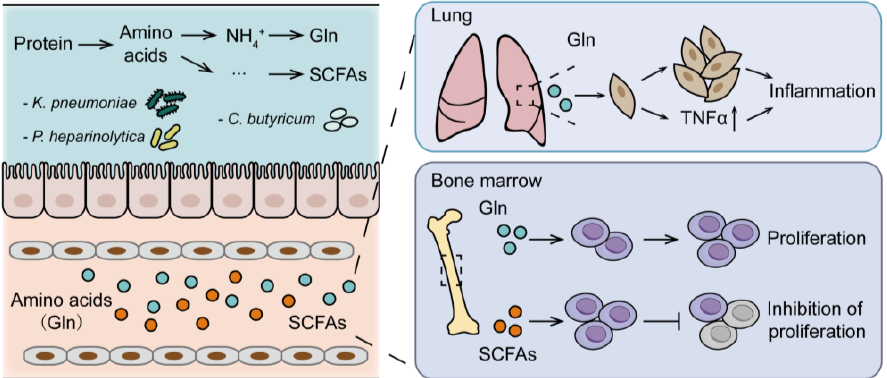
Figure 3. Interaction of gut microbiota and host amino acid metabolism in multiple myeloma. The amino acids are converted to ammonia. Conversely, ammonia is re-utilized by nitrogen bacteria to produce glutamine, wherein the bone marrow, glutamine, which is addicted to MM cells, is utilized by MM cells for proliferation. When it accumulates in the lung, glutamine contributes to the proliferation of lung normal fibroblast cells and elevated secretion of TNF- α for inflammatory infiltration. In addition, the SCFAs produced in the gut are adsorbed and distributed in the bone marrow, alleviating the proliferation of MM